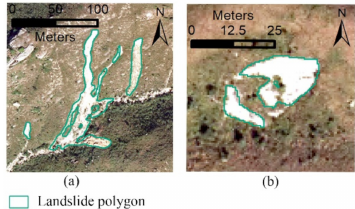
Figure 10. Illustration of complexities of landslide polygon in study area B. ( a ) Example of landslide polygon with holes. ( b ) Example of incomplete landslide